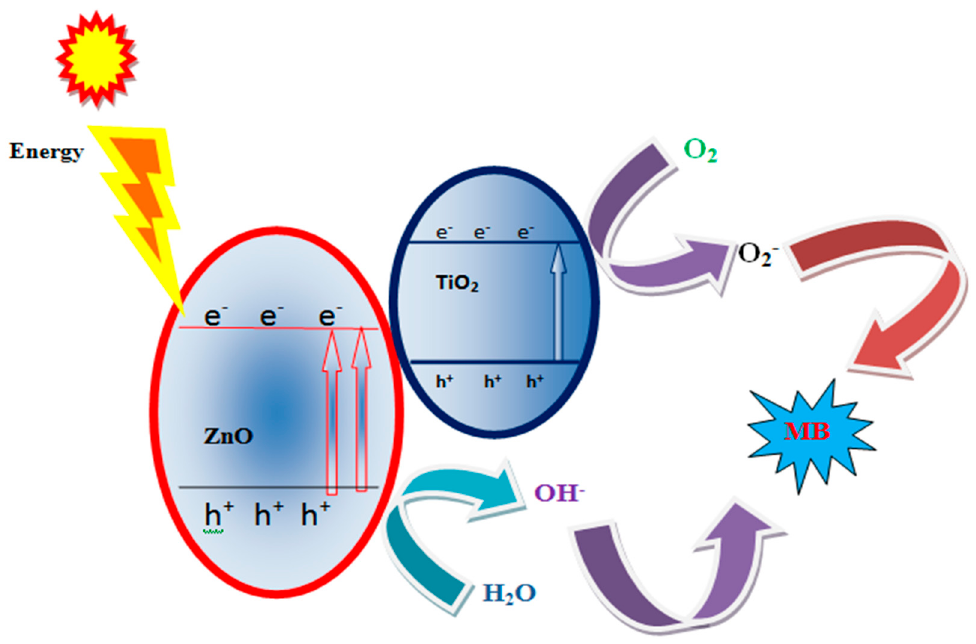
Figure 10. ZnO-doped TiO 2 nanocomposites and their proposed photocatalytic mechanism.